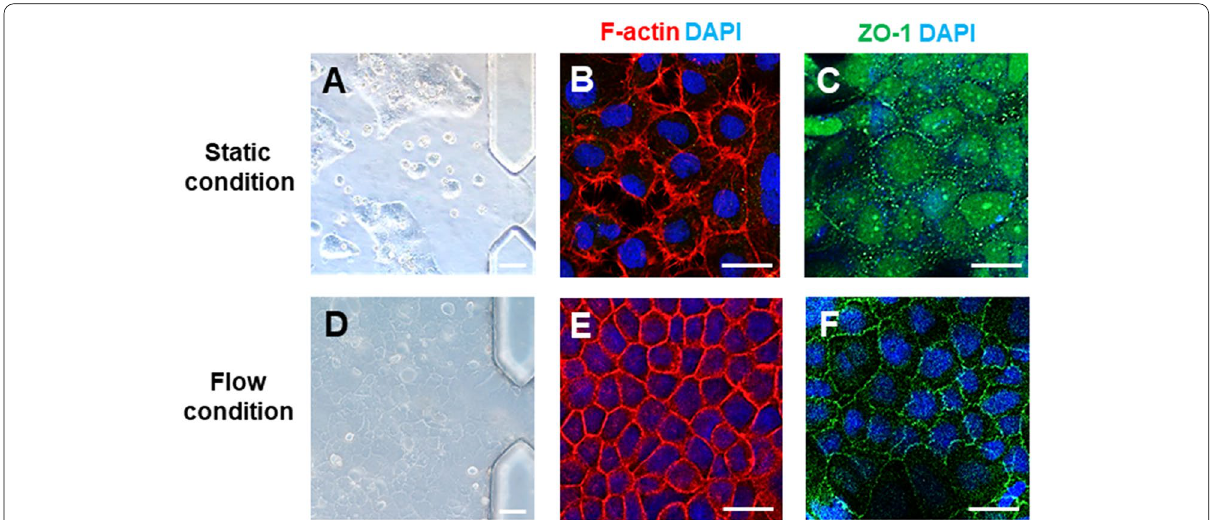
Fig. 3 Morphology of the Caco‑2 epithelial cells cultured in a static culture condition and in the gut‑on‑a‑chip with microfluidic flow for 5 days. A and D are phase contrast views of Caco‑2 cells monolayer. B and E show the distribution of the cytoskeleton protein, F‑actin, in the Caco‑2 cells monolayers. C and F show the distribution of the tight junction protein, ZO‑1, in the Caco‑2 cells monolayers. Scale bars are 25